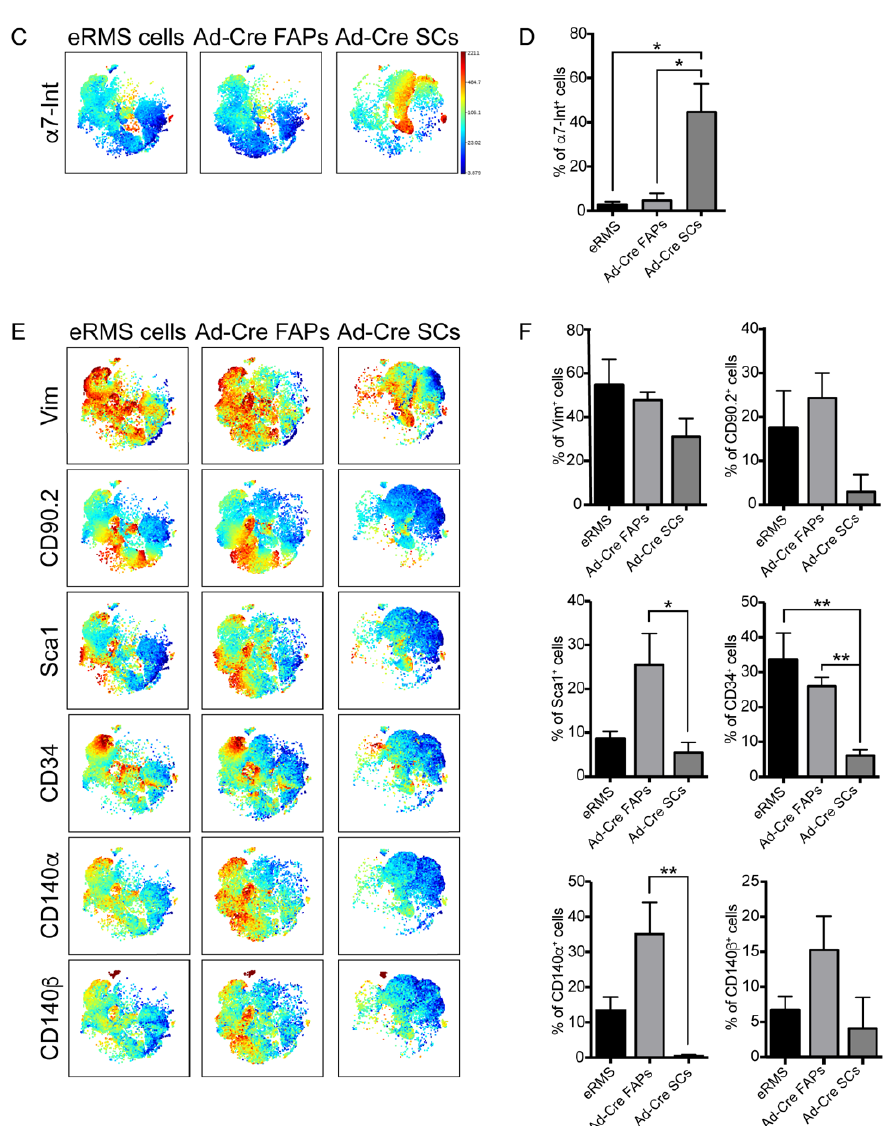
Figure 5. Mass cytometry antigenic-profile comparison of eRMS cells and Ad-Cre FAPs and Ad-Cre SCs. ( A ) Representative viSNE contour plots showing cell-density distribution of eRMS cells and Ad-Cre FAPs and Ad-Cre SCs (red: high density; blue: low density). ( B ) Multidimensional scaling plot (MDS) of eRMS, Ad-Cre FAPs and SCs. ( C ) Representative viSNE maps colored according to the expression level of α7 -Integrin marker (blue: low expression; red: high expression). ( D ) The bar plots quantitate the percentage of cells positive for the expression of the α7 -Integrin marker. ( E ) Representative viSNE maps showing the expression level of the indicated marker. ( F ) The bar plots quantitate the percentage of cells positive for the expression of the analyzed marker . ( D , F ) Cell percentages were assessed on the total number of cells in each sample ( n = 3). The statistical significance was estimated by one-way ANOVA. All data are represented as mean ± SEM, and the statistical significance was defined as * p < 0.05; ** p < 0.01.